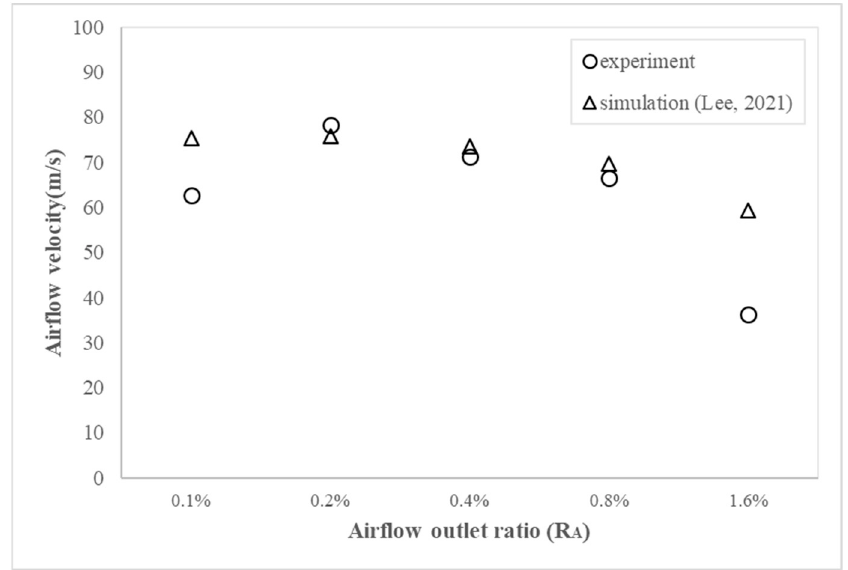
Figure 18. Comparison of the velocity of air flow from the OWC with various outlet ratios.